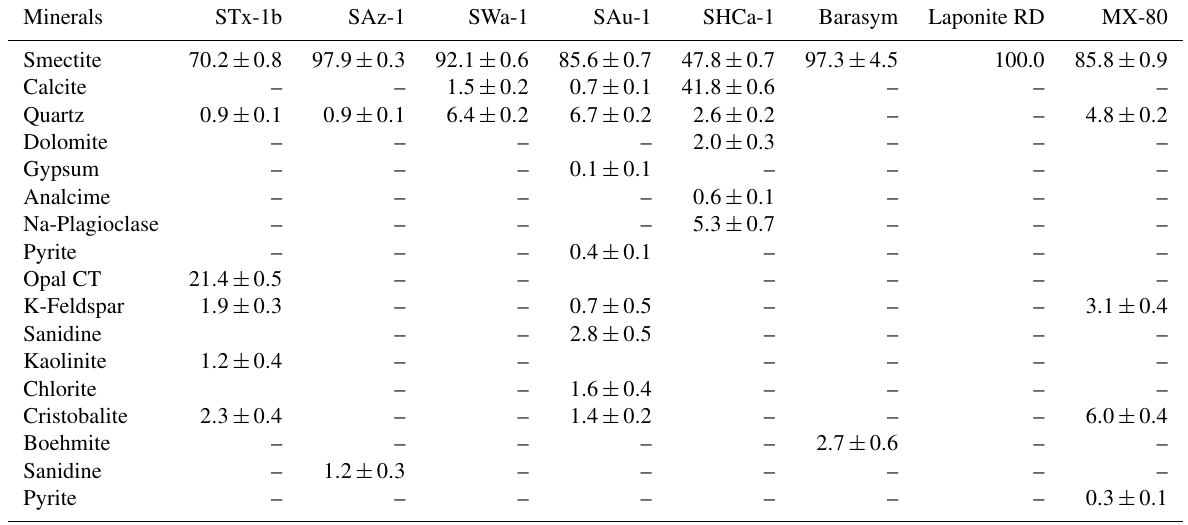
Table 2. Chemical composition of the investigated smectites. Smectite